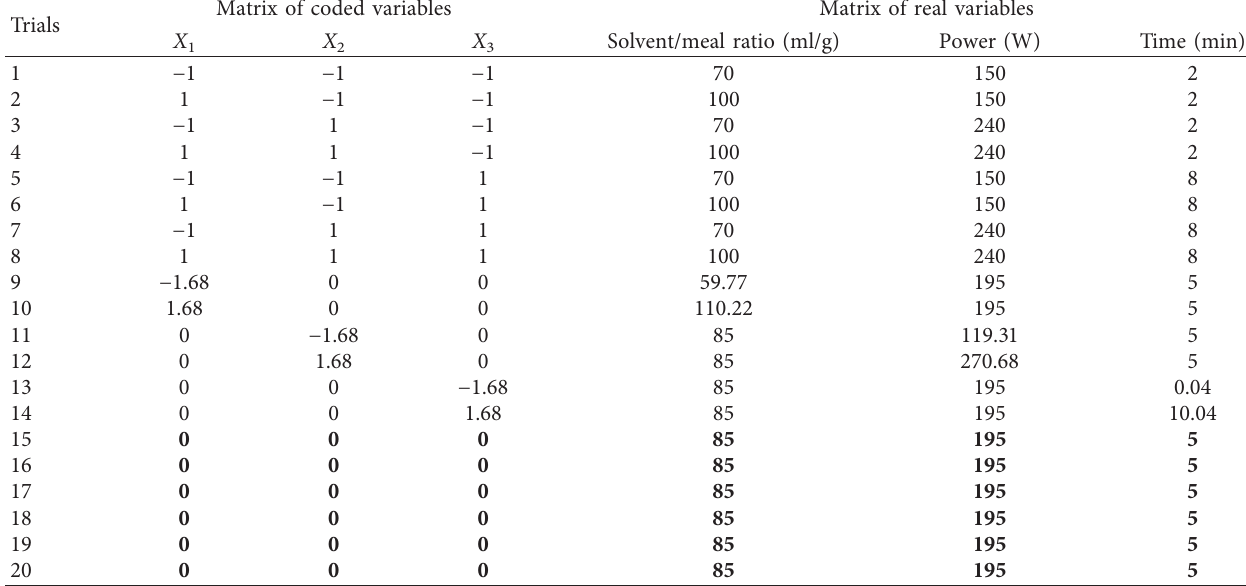
Table 2: Experimental design in coded and real variables.